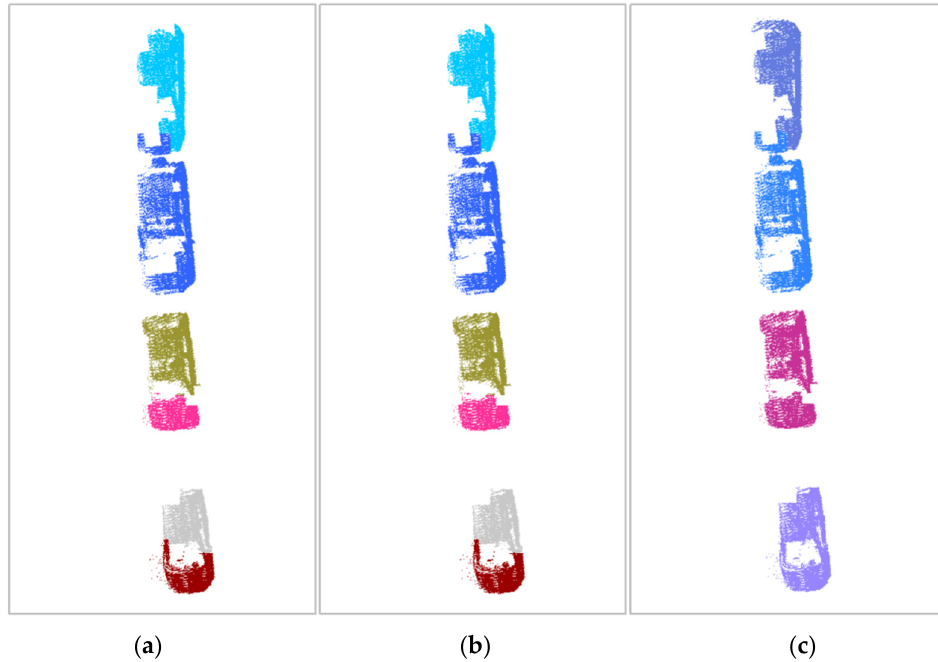
Figure 19. Another example of neighborhood splitting and merging effect. Neighborhood segmentation result by region growth based relative tension ( a ); on the basis of the result in ( a ), neighborhood splitting result ( b ); on the basis of the result in ( b ), neighborhood merging result ( c ). Note: Different neighborhoods are displayed in different colors.